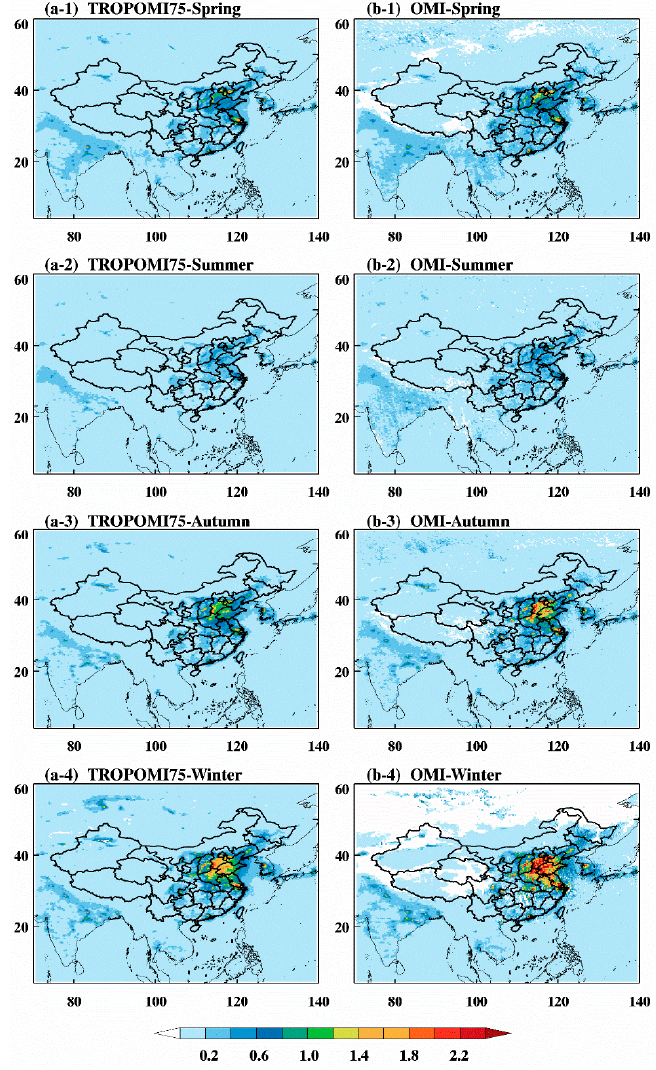
Figure 3. Seasonal mean tropospheric NO 2 VCDs binned at 0.25 ◦ × 0.25 ◦ in spring (first row), summer (second row), autumn (third row) and winter (fourth row) over China from the ( a ) TROPOMI75 and ( b ) OMI (units: 10 16 molec cm − 2 ).